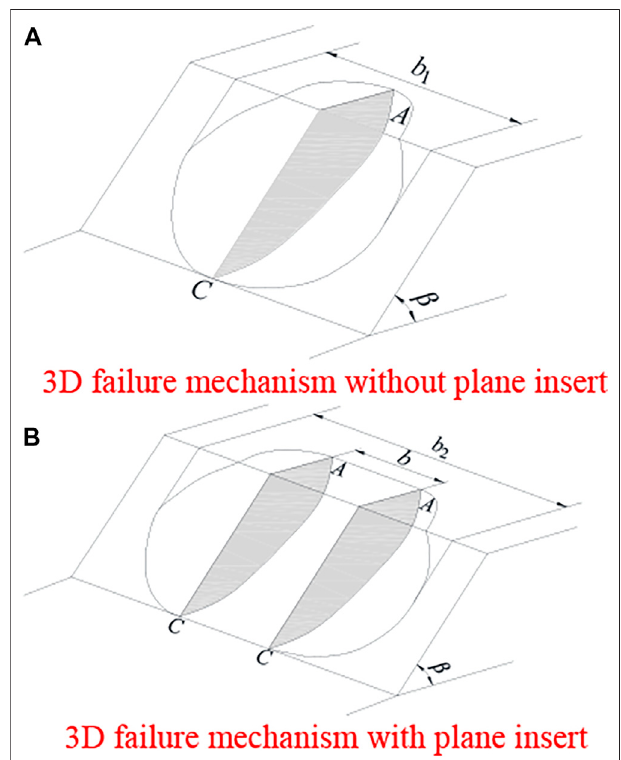
FIGURE 2 | 3D failure mechanism. (A) 3D failure mechanism without plane insert, (B) 3D failure mechanism with plane insert.